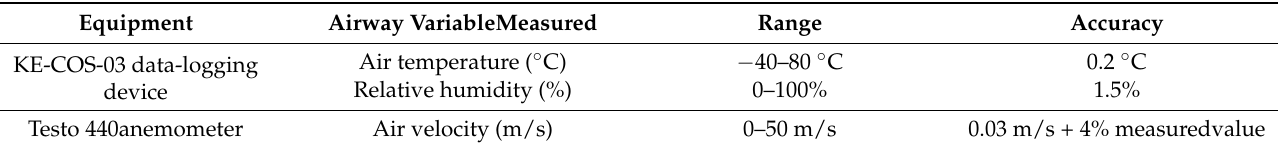
Table 2. General characteristics of the measurement